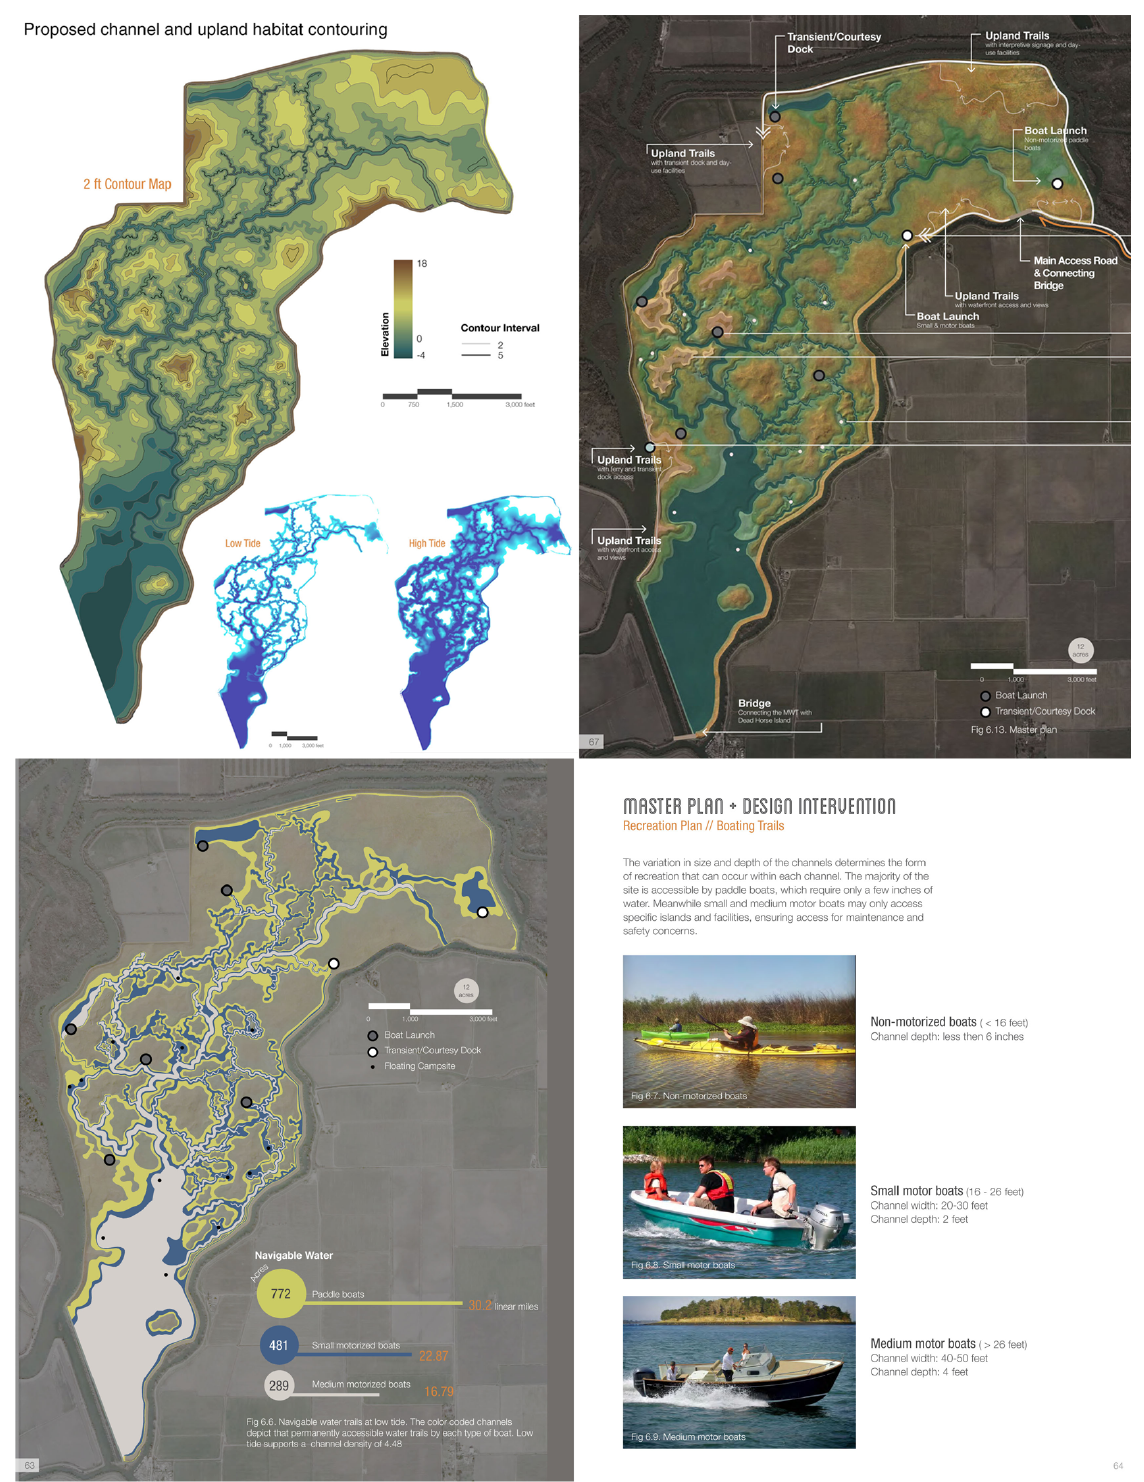
Figure 8. “Navigating the Delta: The McCormack-Williamson Tract” (2014); Excerpts from a Planning and Design Project by UC Davis landscape architecture student Katie Herman, including ecological restoration concept (top) and overlay of recreation planning (bottom). Katie’s project was developed in an advanced planning and design studio that expanded upon existing planning frameworks for the North Delta Flood Control Project, building a vision for incorporating aquatic and terrestrial recreation within the new ecological and hydrological conditions of an intentionally inundated and res- culpted landscape. Based on the growing recreational demand in the Delta, this plan proposes implementing a network of boating trails, campsites, and interactive wayfinding media for the new waterways. The project was coordinated with and advised by representatives from the California Department of Water Resources, The Delta Conservancy and the Na- ture